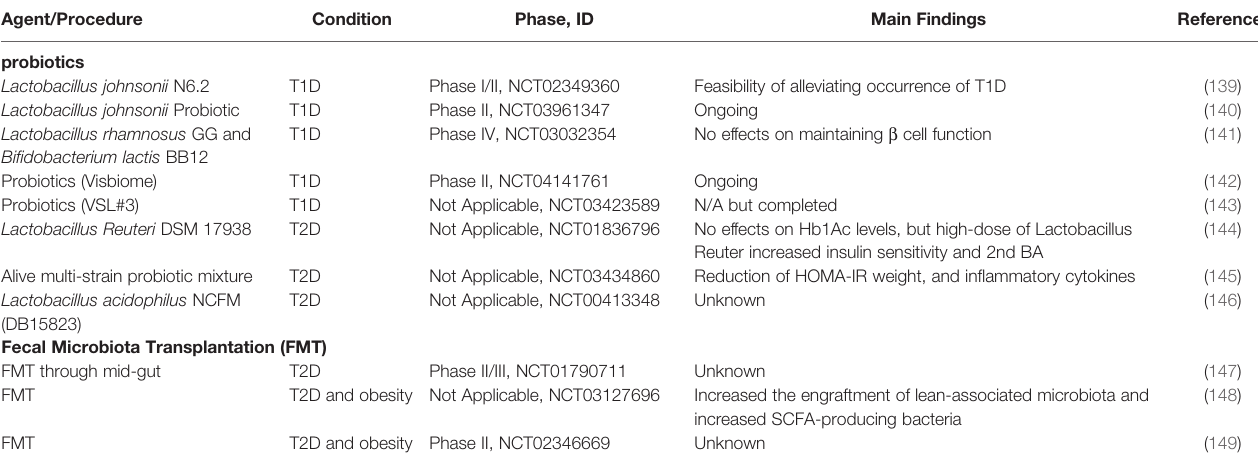
TABLE 3 | Summary of current clinical trials evaluating the ef fi cacy of probiotics or FMT on diabetes.